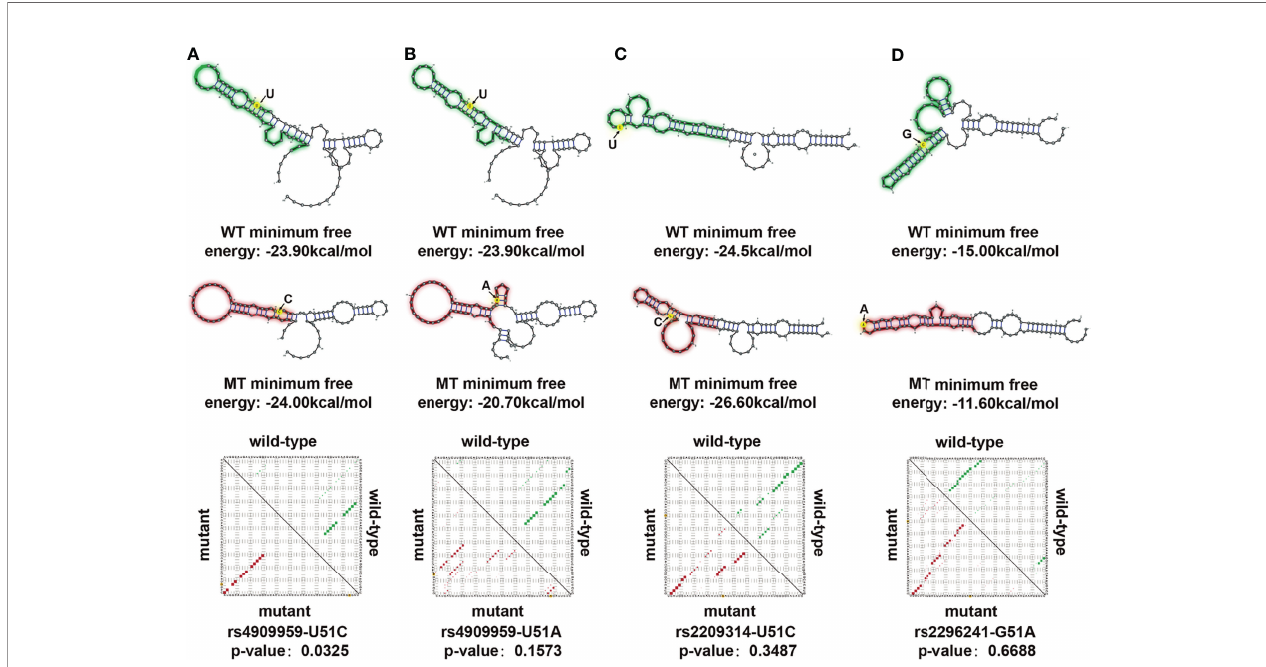
FIGURE 5 | Allosteric effect analysis of CYP24A1 induced by single-nucleotide polymorphisms (SNPs). (A) RNA structure disturbance deduced by the rs4909959 UC allele. Changes in structure were identi fi ed by RNAsnp. Green represents wild type (WT), red represents mutant type (MT). SNP position is colored in yellow. Minimum free energy describes the stability of the RNA structure. The base pair probability of the local RNA secondary structure is shown in the dot plot, with the upper triangle representing wild type (green) and the lower triangle representing mutant type (red). (B) RNA structure disturbance deduced by the rs4909959 UA allele. (C) RNA structure disturbance deduced by the rs2209314 UC allele. (D) RNA structure disturbance deduced by the rs2296241 GA allele.